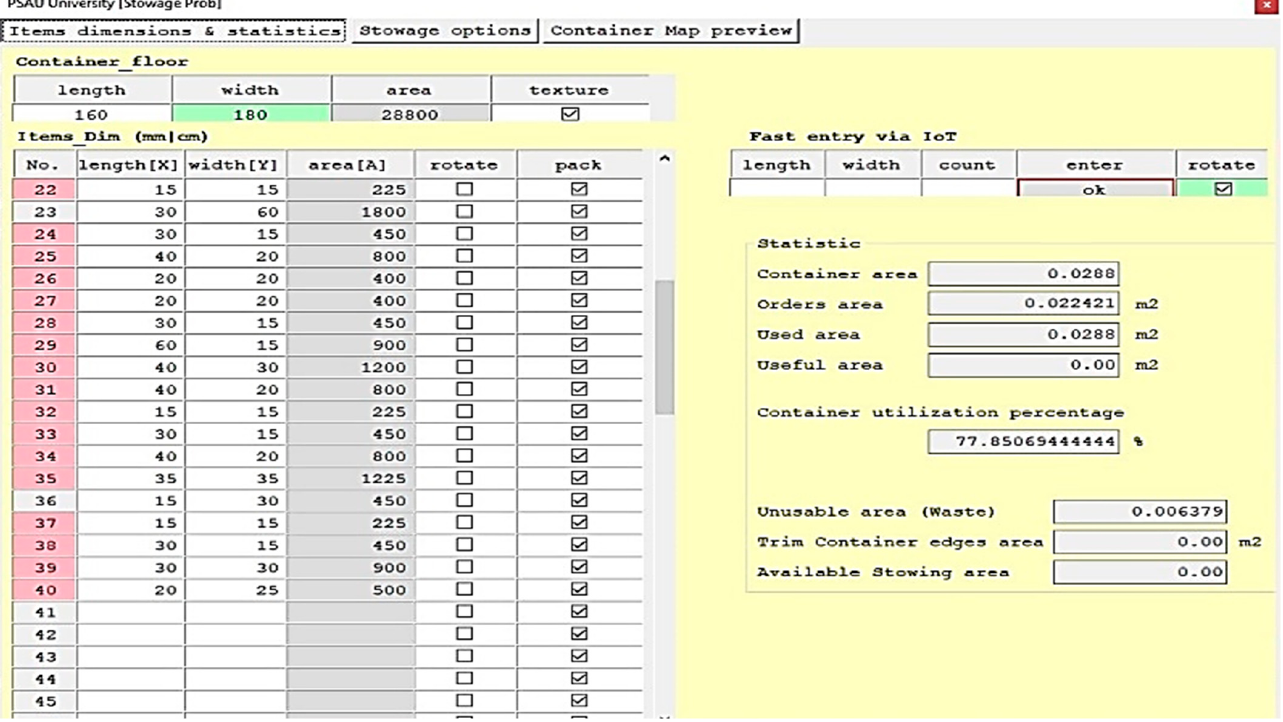
Figure A10. The container utilization by ant-colony algorithm for third station on the distribution path.